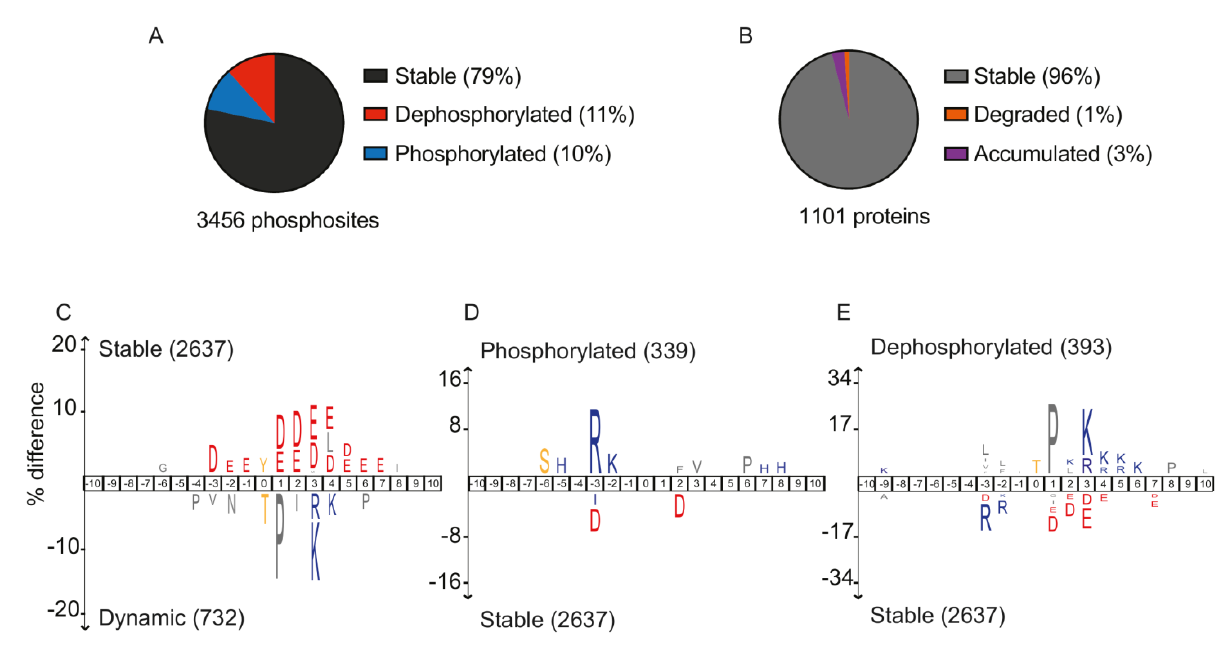
FIGURE 1: Dynamic phosphosite behavior during mitotic exit correlates with sequence surroundings. (A) Fractions of stable (black), dephosphorylated (red) and phosphorylated (blue) phosphosites during mitotic exit. (B) Fractions of stable (grey), degraded (orange) and accumulated (purple) proteins. (C-E) IceLogo motif analyses to reveal sequence elements enriched around phosphorylation sites. These analyses compared (C) dynamic versus stable, (D) phosphorylated versus stable and (E) dephosphorylated versus stable phosphosites. The phosphorylated residues are at position ‘0’. Larger letter size indicates increasing enrichment, cutoff for enrichment detection was p =